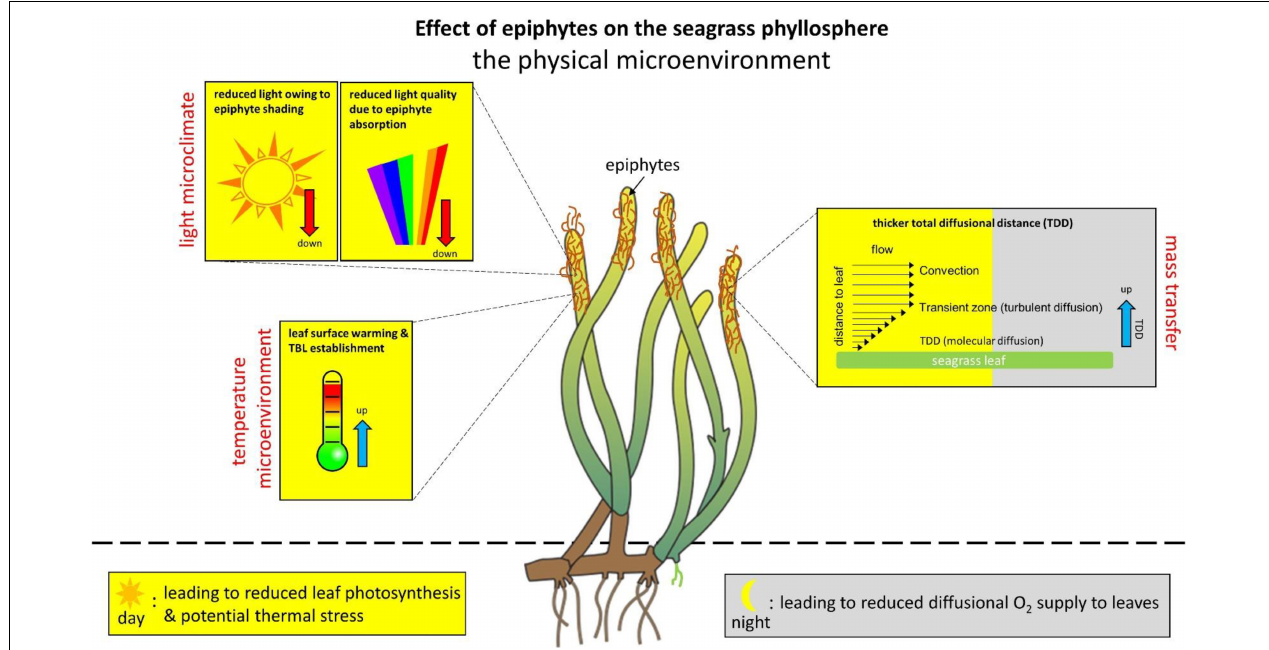
FIGURE 1 | Effect of epiphytes on the physical microenvironment in the seagrass phyllosphere. The changes in the phyllosphere physical microenvironment are shown as an effect on seagrass leaves with epiphytic biofilms as compared with bare leaves and/or bare leaf parts. The seagrass phyllopshere dynamics are shown over diel cycles, where the yellow marked areas represent alterations during daytime and gray marked areas represent changes during night-time. Blue arrows indicate an increase. Red arrows indicate a